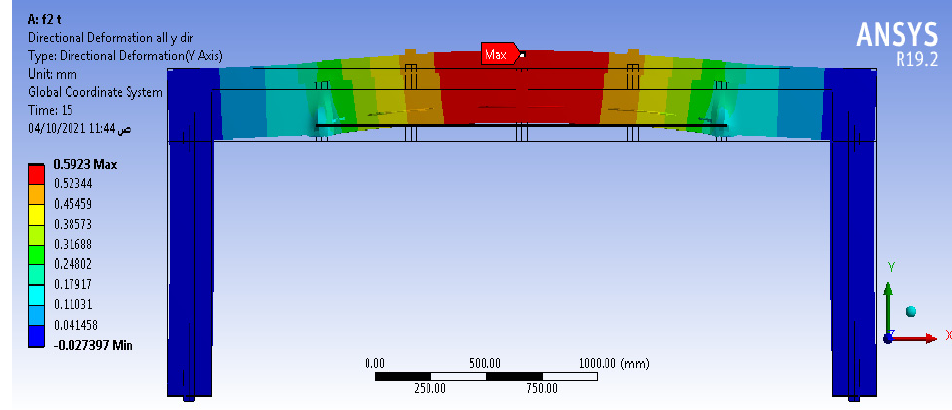
Figure 3. Pre − stressing of tendons of sample F 2 .